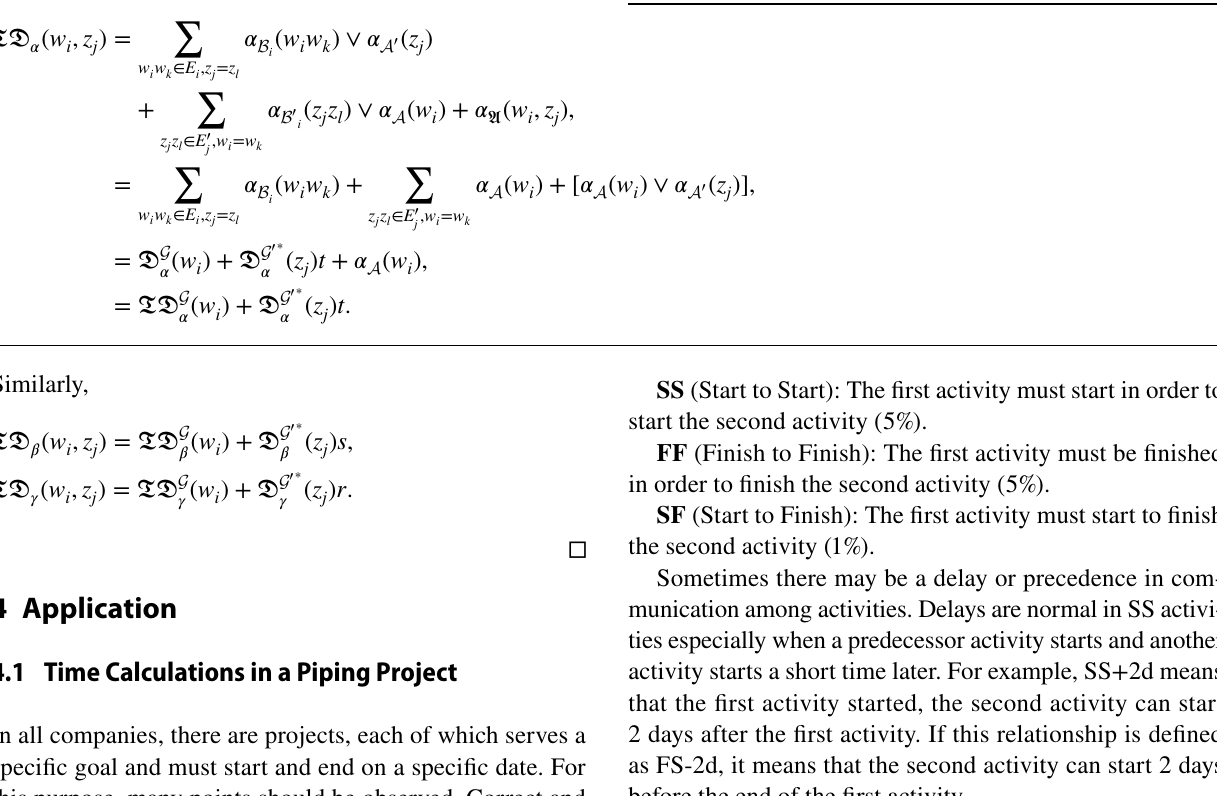
Symbol Type of activity Placing concrete